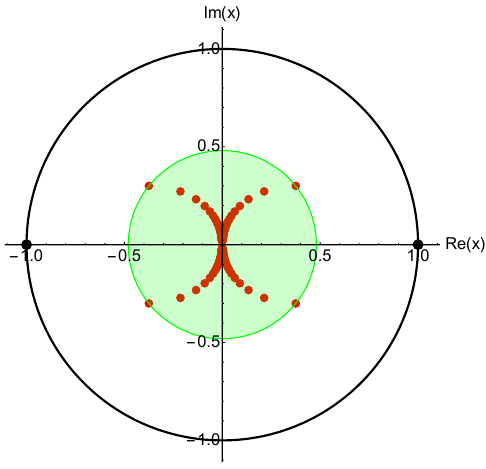
Figure 3 . Analytic structure of the P func- tions in the x -plane for h = 1. The unit circle separates the (cid:12)rst sheet ( j x ( u ) j > 1) from the second sheet ( j x ( u ) j < 1). The inner green disc represents the convergence region of the power expansions of P A , the red dots corre- spond to the positions of the branch points on the second